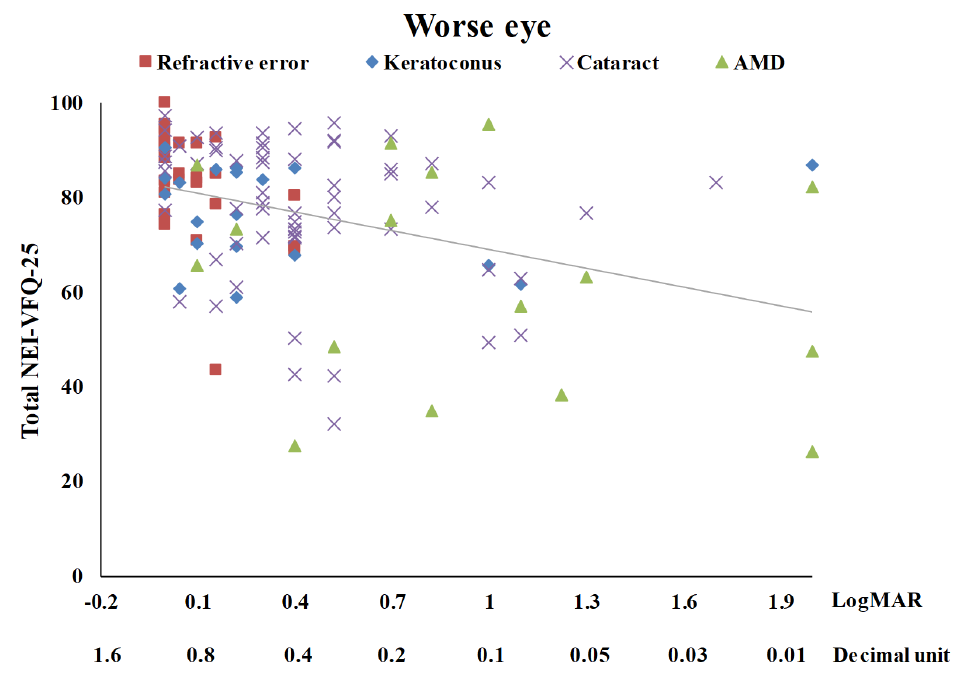
Figure 3. The scatter plot between total NEI-VFQ-25 score and the best-corrected visual acuity for the worse eye (r = − 0.38, p < 0.0001).